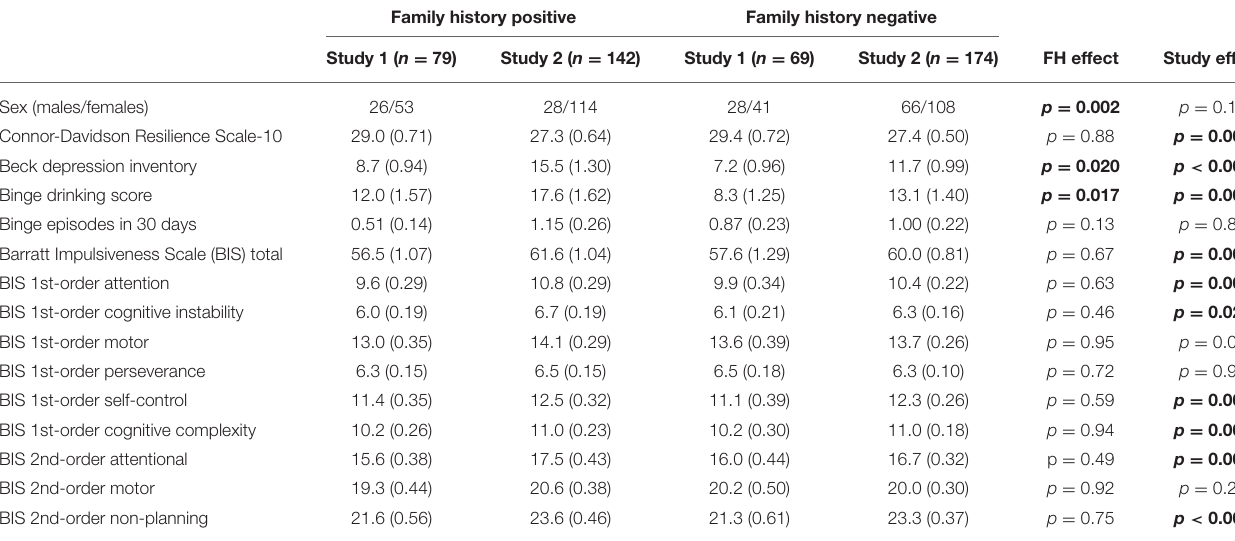
TABLE 1 | Sample characteristics of individuals with or without a family history of alcohol use